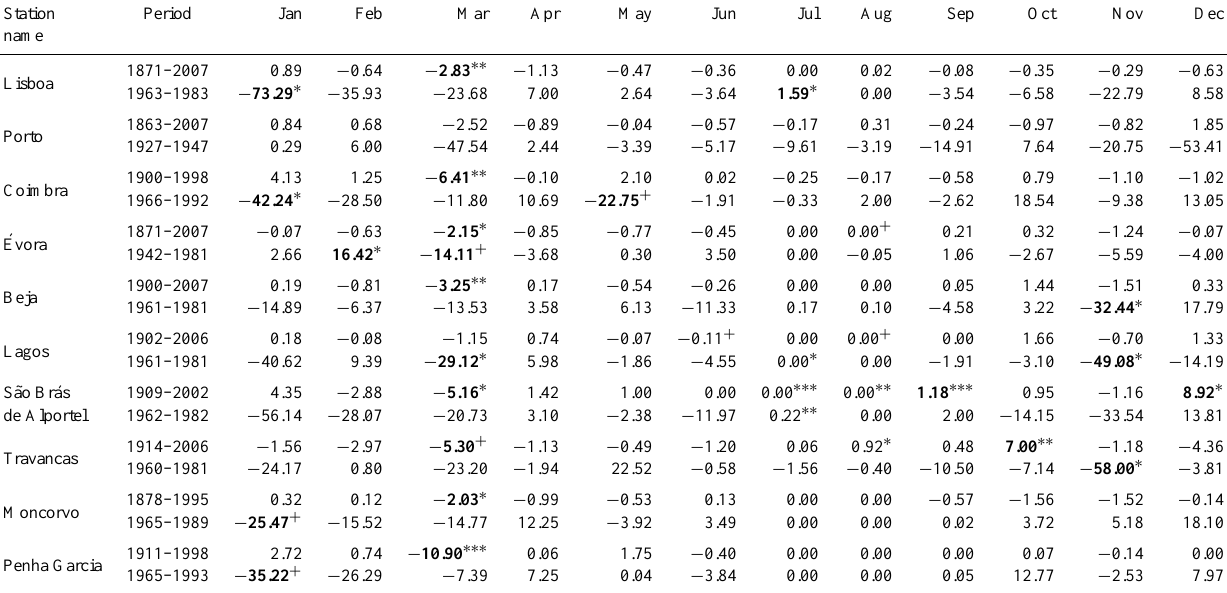
Table 2. Sen’s estimator of the monthly precipitation trends (mm/decade) and the respective confidence levels: + 90%, ∗ 95%, ∗∗ 99% and ∗∗∗ 99.9%. The data are for the full period and for periods of negative trend in annual precipitation, which were selected for each time series based on the breakpoints located in the partial trend